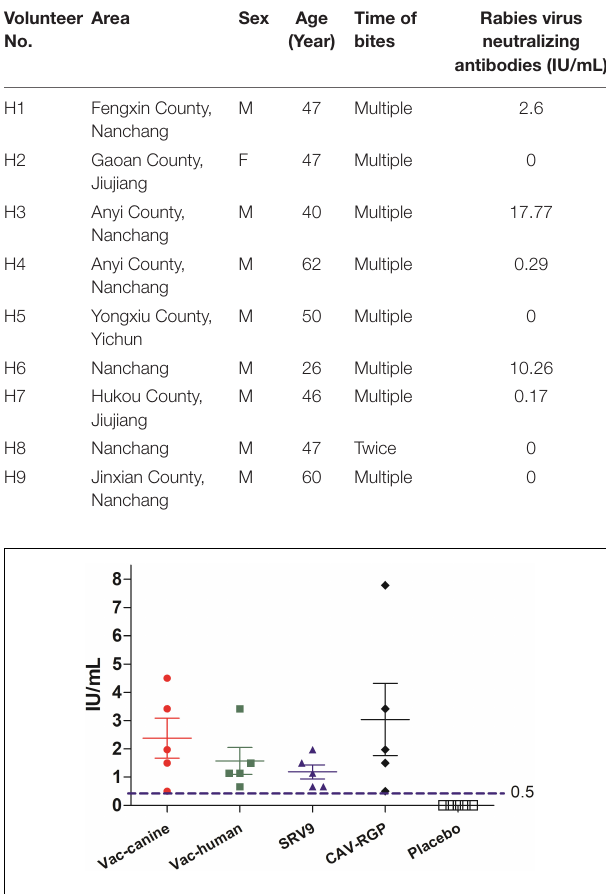
TABLE 4 | Results of serologic rabies virus neutralizing antibody titers (IU/ml) in nine volunteers from Jiangxi province. Volunteer No.